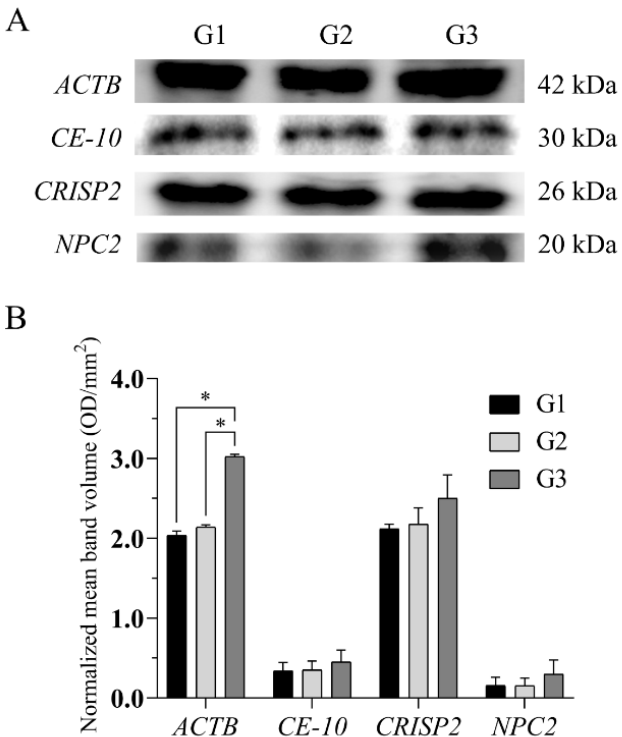
Figure 5. Protein expression levels in the epididymal spermatozoa of dogs ( Canis lupus familiaris ) in different age groups: G1, G2, and G3 blotted with antibodies ( A ). Each column indicates the normalized value (mean ± SE) of protein expression from three replicates. Protein expression represents band optical density (OD) which is significantly different among the age groups. * Significant at p < 0.05 ( B ).